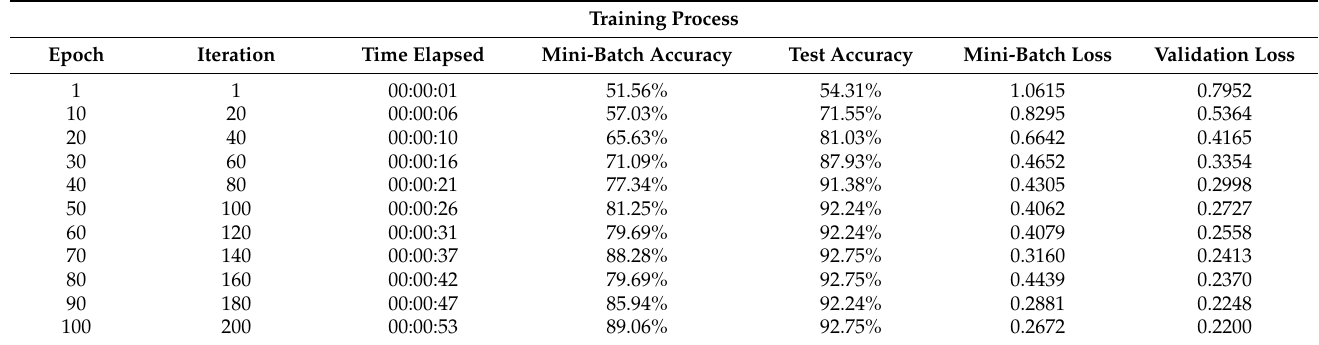
Figure 10. Loss process of the model with the accuracy in the test set (black line) and the training set (blue line). Tables 8 and 9 present the resulting confusion matrix and accuracy for classifying apical lesion, respectively. From Table 9, the probability of misjudgment of being sick or